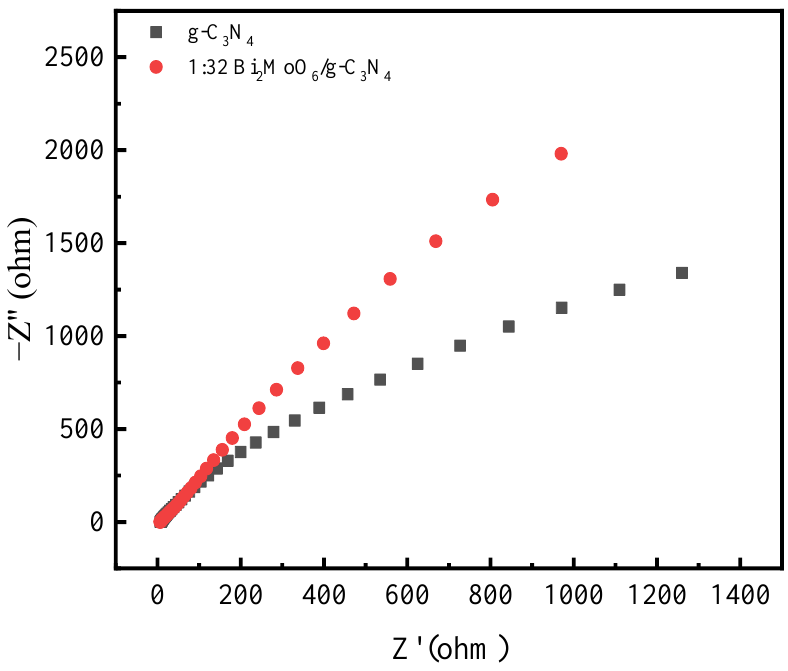
Figure 6. Electrochemical impedance spectra over g-C 3 N 4 and 1:32 Bi 2 MoO 6 /g-C 3 N 4 as working elec- trode.